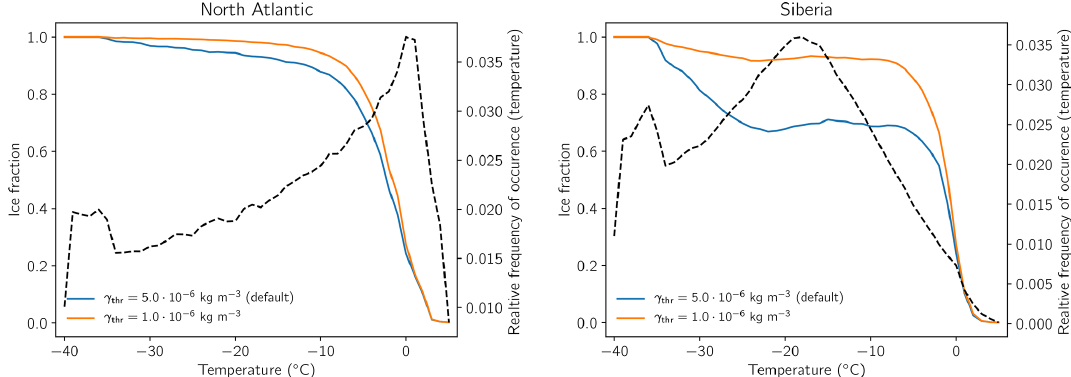
Figure 5. Temperature-binned averaged ice fraction (IWC / (LWC + IWC)) in the North Atlantic (320–10 ◦ E, 50–70 ◦ N) and in Siberia (50– 130 ◦ E, 50–70 ◦ N). The dashed line shows the relative frequency of occurrence for the respective temperature